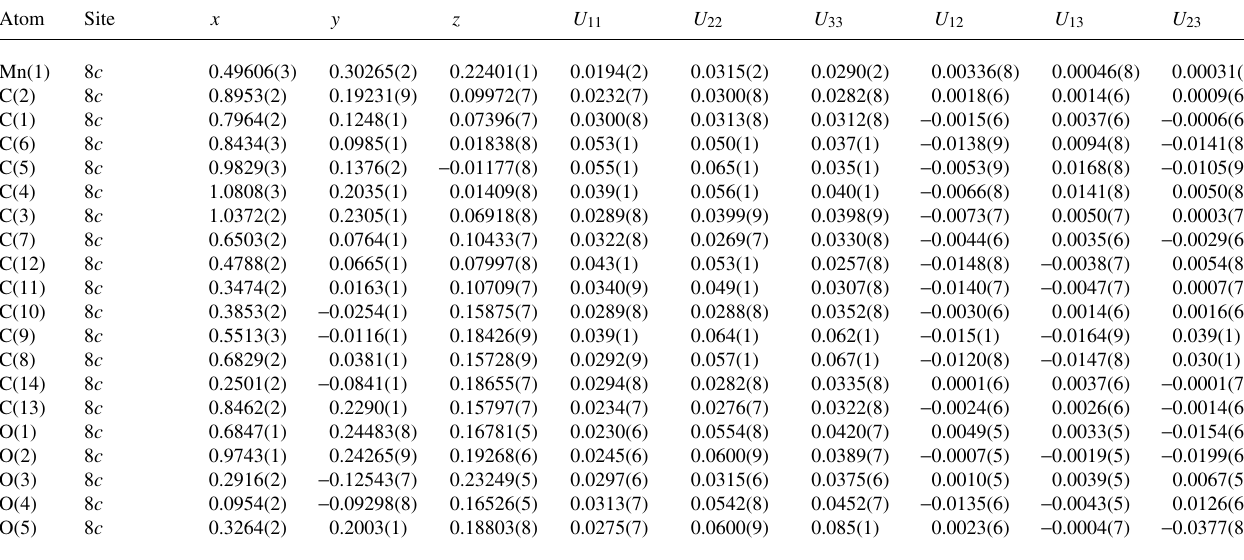
Table 3. Atomic coordinates and displacement parameters (in Å 2 )